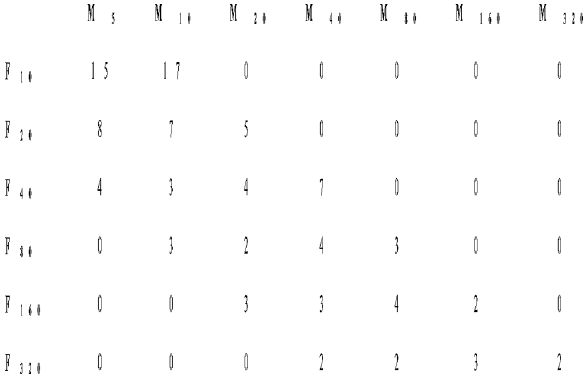
Figure 2. Schematic depiction of the experimental design used in Wallace [ 3 ] . Depicted is the minimum number of trials performed for each of the combinations of six levels of the number of females ‘F’ and seven levels of the number of males ‘M’.